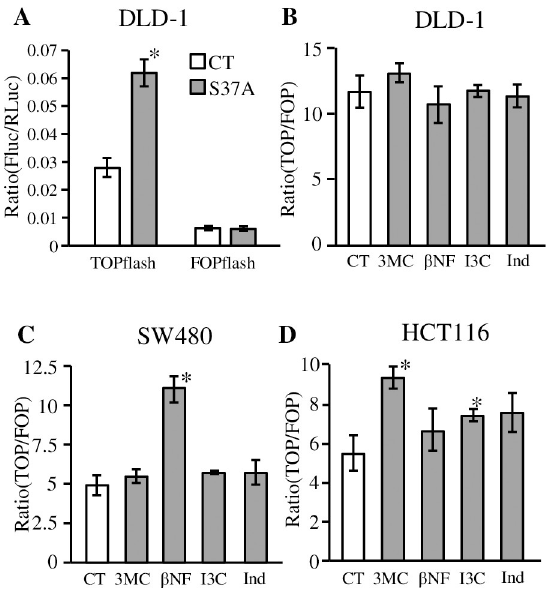
Fig 3. Effects on β -catenin/Tcf-dependent transcriptional activity upon exposure of various AhR ligands. A ) DLD-1 cells were transfected with TOPflash or FOPflash reporter vectors and pRL-CMV together with empty vector (CT) or pCI- β catS37A, the mutated β -catenin expression vector (S37A). The cells were lysed 48 hours after transfection, and luciferase activities were measured. Data represent the average of normalized firefly luciferase/ Renilla luciferase activities of three independent experiments. B-D ) TOPflash or FOPflash reporter vector was transfected into B ) DLD-1 cells, C ) SW480 cells, or D ) HCT116 cells together with mutated β -catenin expression vector (S37A). After transfection, cells were exposed to 3MC (1 µ M), β NF (1 µ M), I3C (3 µ M), Ind (3 µ M), or 0.1% DMSO (solvent control, CT) for 8 hours. Data represent average of TOPflash/FOPflash ratios from three independent experiments. Statistically significant differences are denoted by asterisks ( � p <